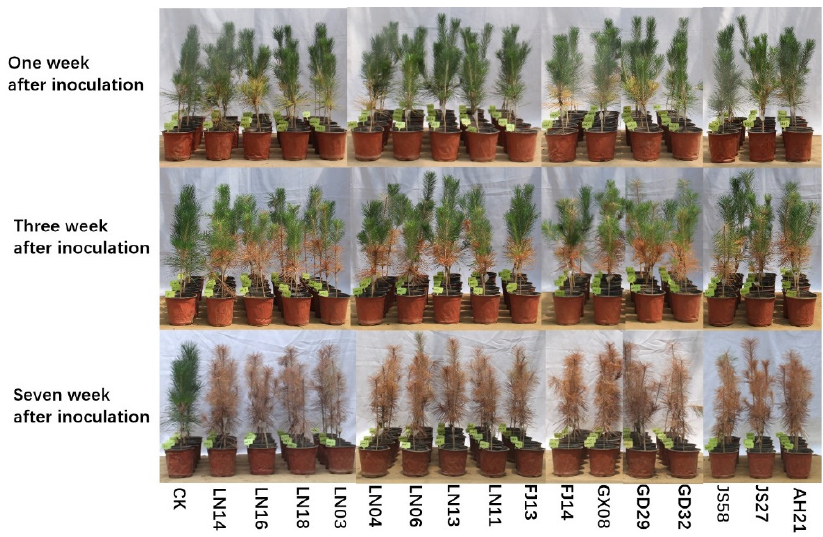
Figure 4. The pine wood nematode (PWN) Bursaphelenchus xylophilus disease index in P. thunbergii after inoculation with PWN strains. Sixteen reference numbers represent sixteen PWN isolates from different regions. ( a ) Disease index of the 8 northern strains. ( b ) Disease index of the 8 south- ern strains. 3.3. Comparison of the Pathogenicity of PWN Strains from Southern and Northern China to P. tabuliformis The 16 PWN strains were inoculated into 2-year-old P. tabuliformis potted seedlings. After inoculation, symptoms of pine disease appeared: the bases of the needles through- out the pine seedlings began to turn yellow, and the color change gradually spread to the needle tips. Then, the color of the needles deepened to reddish brown as the disease pro- gressed. The P. tabuliformis seedlings wilted and died, but the needles rarely dropped when the seedlings died. The first onset of the disease in the pine seedlings typically oc- curred around the second week, and the onset time in the seedlings inoculated with the southern strain was generally earlier than that in seedlings inoculated with the northern strain. In the 4th to 5th weeks after inoculation, the inoculated pine seedlings entered the middle stage of disease progression. In the 10th week, the mortality rate of P. tabuliformis inoculated with GD32 was 100%, while FJ13 was only 0% (Table 6). After 38 days, three pine seedlings, one of each inoculated with LN03, LN04, or FJ14, had died. At the 10th week after inoculation, the average mortality rate of the pine seedlings inoculated with northern strains was 62.5% ± 26.1, and the average mortality rate of the pine seedlings